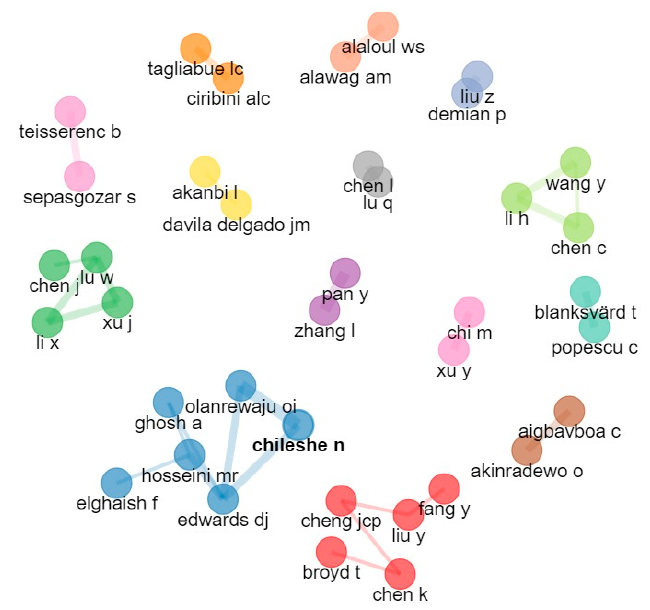
Figure 7. Collaboration network analysis, performed with Biblioshiny version 4.0.